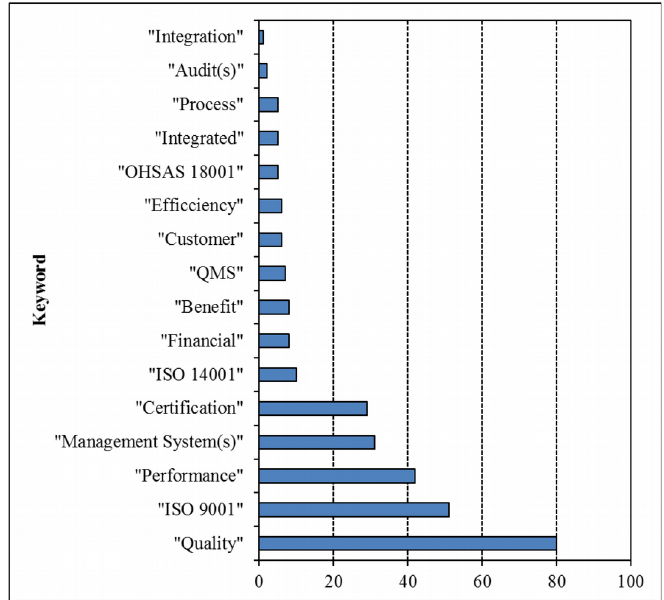
Figure 9. ISO 9001 QMSC articles keywords